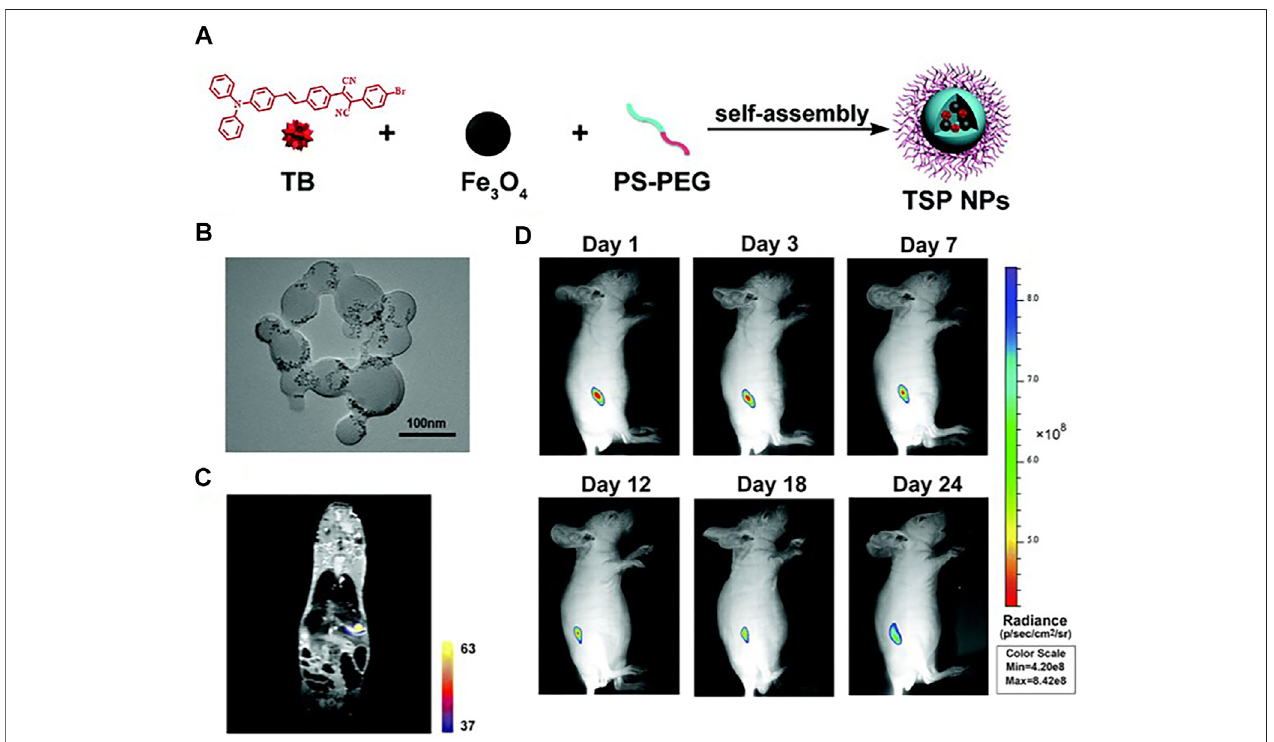
FIGURE 8 | (A) The fabrication of TSP NPs. (B) TEM image of TSP NPs. (C) MPI-MRI fusion images in vivo . (D) Representative in vivo fl uorescence images of the mouse subcutaneously injected with HuH-7 cells from day 0 to day 24. Reproduced with permission from Meng et al. (2019). Copyright 2019, Royal Society of